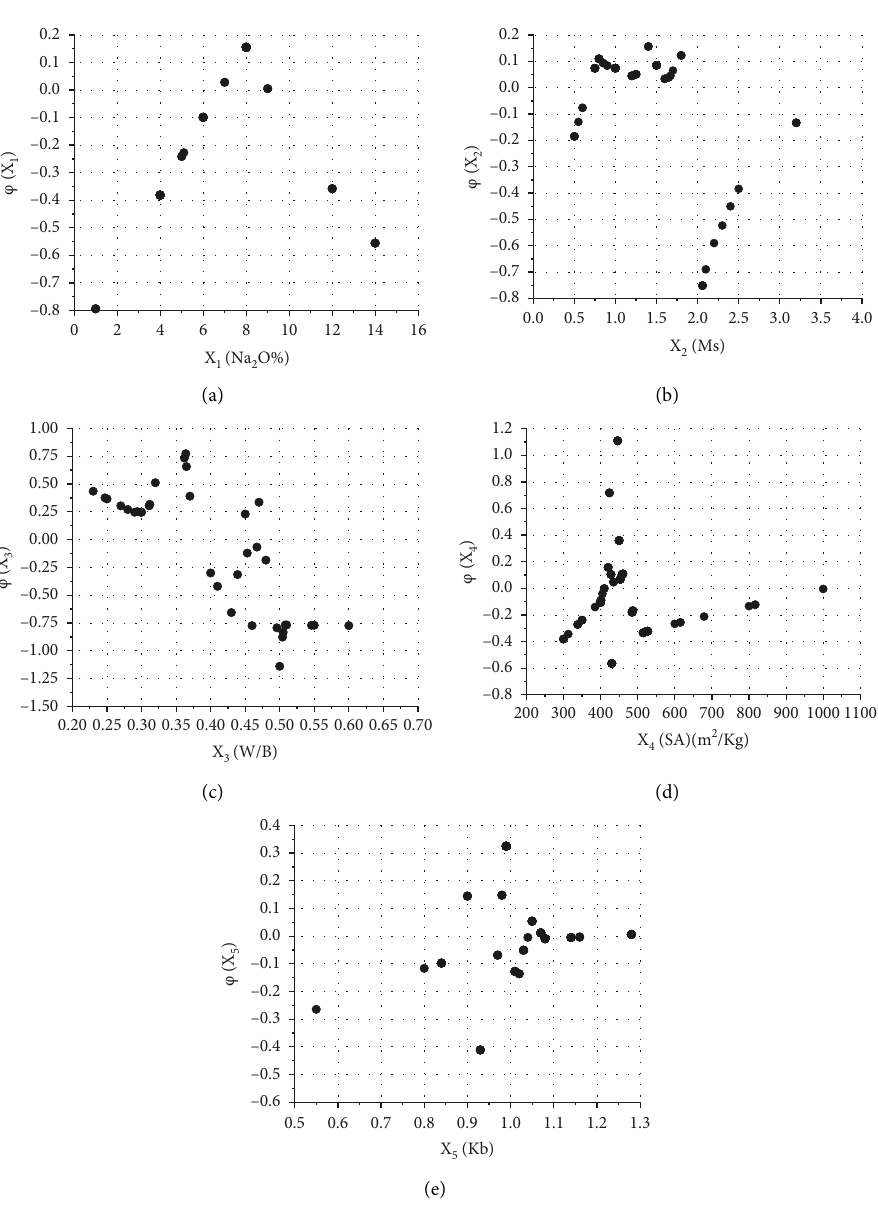
Figure 4: Relationship between input parameters and their corresponding response surface functions in the case of 3 d compressive strength. (a) X 1 (Na 2 O%) and φ